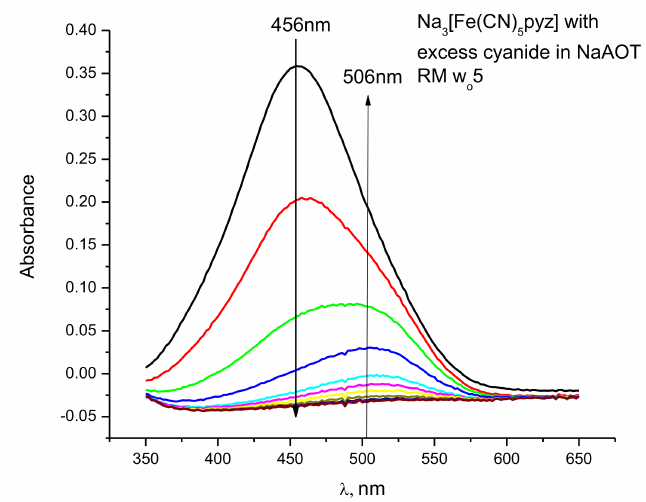
Figure 3. Trapping experiments for [Fe(CN) 5 OH 2 ] 3 − with 0.05M sodium cyanide in the water droplet in a w 0 5 AOT/isooctane RM. The concentration of [Fe(CN) 5 pyz] 3 − is approximately 5 × 10 − 5 M.